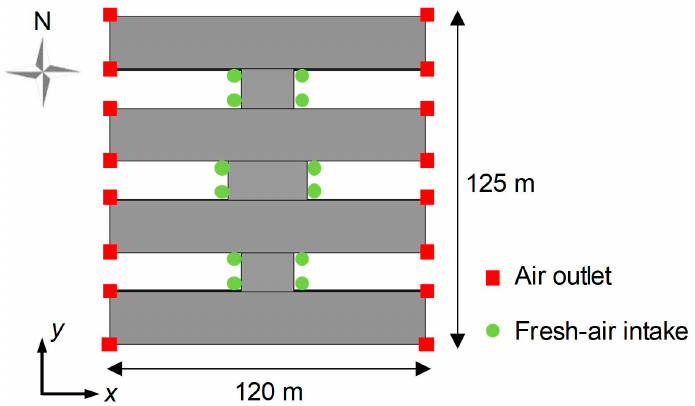
Figure 15. FDS model of the conceptual design (building height is 4 m) of the Huoshenshan Hospital.